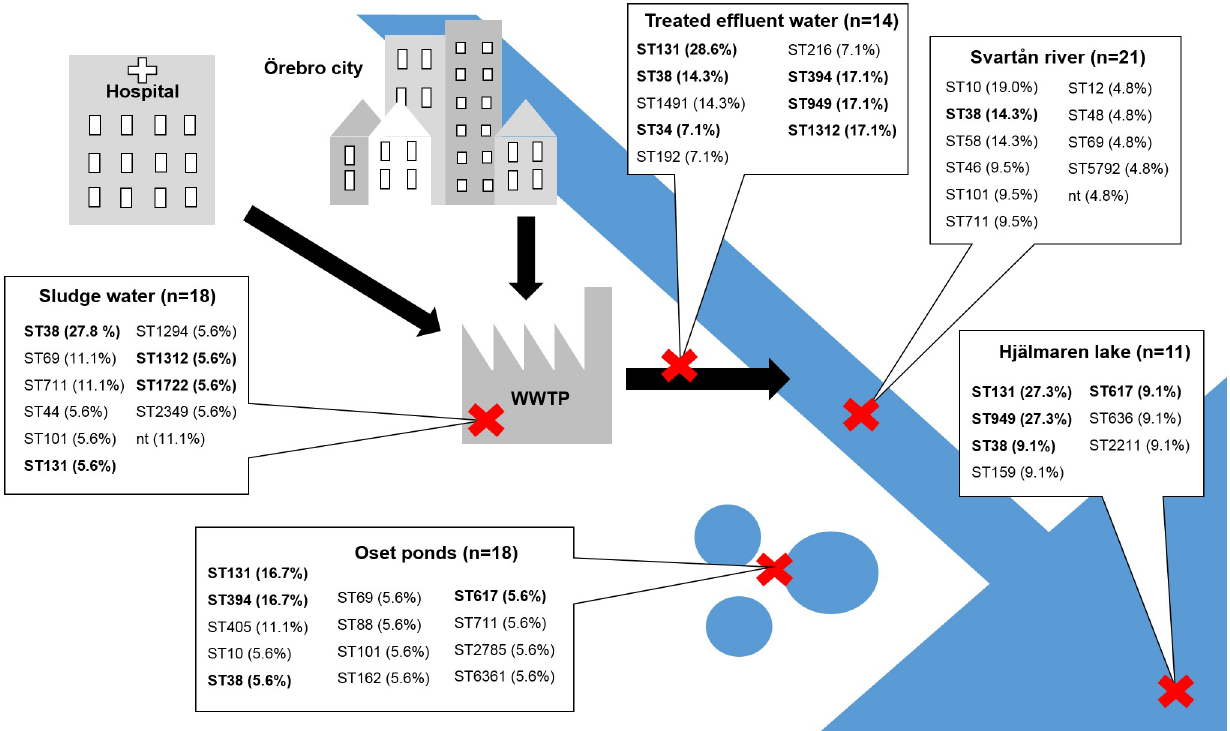
Fig 1. Schematic map of the study area. The red crosses indicate the sampling locations at the wastewater treatment plant (WWTP) and in Svart å n River, Hja¨lmaren Lake, and Oset ponds. Six water samples were collected from each sampling site (three in June and three in October). Presented in the figure are also the number of isolates included from each site and the sequence types (ST) found in the respective locations., STs in bold were also found among the clinical isolates.